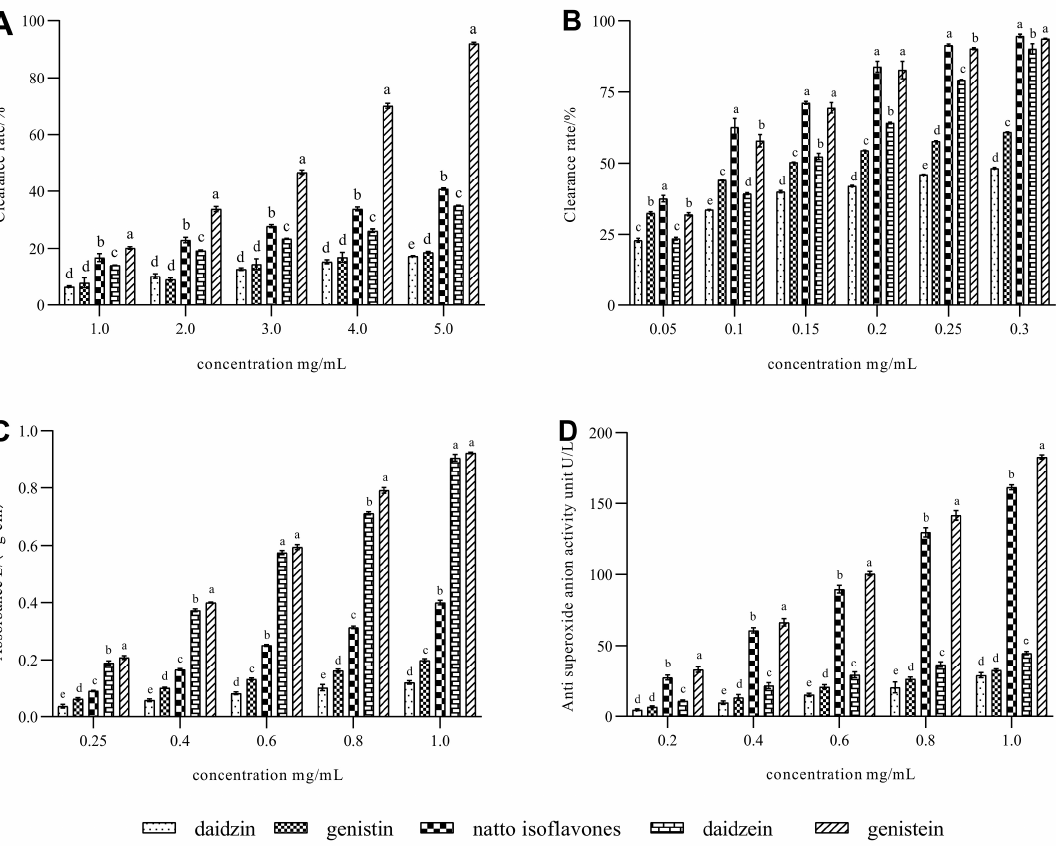
Figure 6. Antioxidant capability of various isoflavone standards and the extract isoflavone from natto. ( A ) DPPH radical scavenging rate; ( B ) ABTS radical scavenging rate; ( C ) Ferric Reducing Antioxidant power capacity; ( D ) O 2· − radical scavenging capacity. Data are presented as the means ± SD of three replications. Different letters represent significant differences ( p < 0.05).